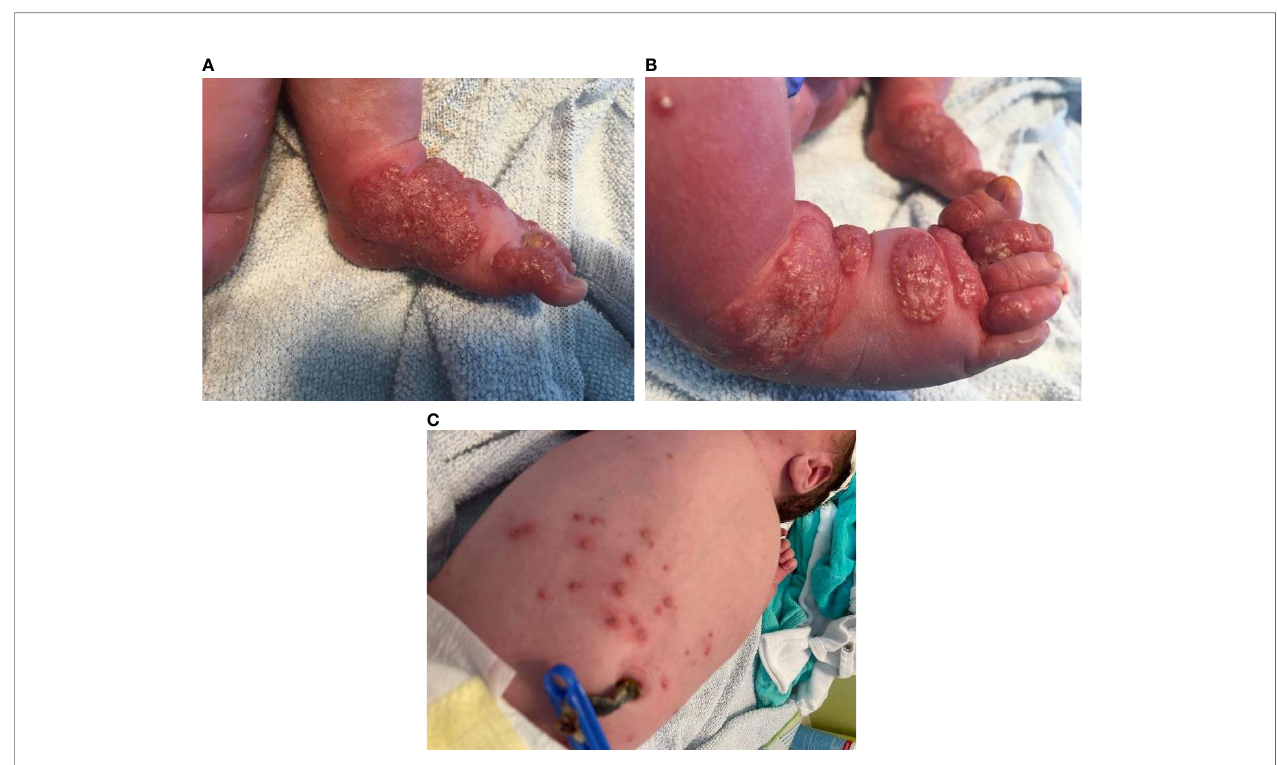
FIGURE 1 | (A , B) Papulo-pustular lesions on an erythematous base on the feet. (C) Scattered papules with central vesicles on the body in a newborn with chronic granulomatous